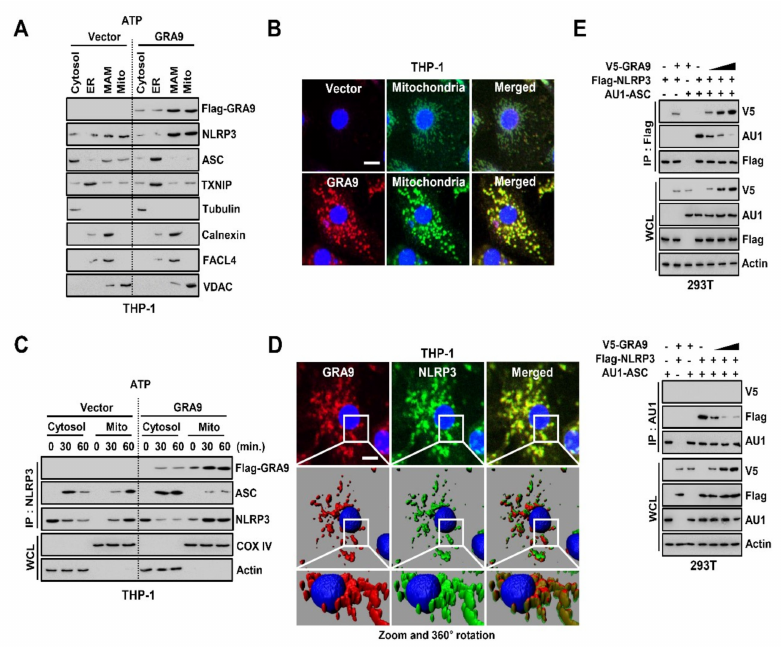
Figure 2. GRA9 associates with NLRP3 inhibiting the binding of ASC in mitochondria. ( A ) Subcellular fractionation of THP-1 cells stably expressing either Vector or GRA9 primed with LPS (100 ng mL − 1 ) and stimulated with ATP (5 mM). Cytosolic, endoplasmic reticulum (ER), mitochondrial-associated membrane (MAM) and mitochondrial fractions were fractionated and analyzed for GRA9, NLRP3, and ASC by immunoblotting (IB). Purify of the fraction was assessed by blotting for TXNIP (thioredoxin-interacting protein; ER protein), tubulin (cytosolic protein), calnexin (MAM protein), FACL4 (acyl-CoA synthetase 4; MAM protein), and VDAC (voltage-dependent anion channel; mitochondrial protein). ( B ) Fluorescence confocal images in THP-1 cells expressing either Vector or rGRA9 were primed with LPS and stimulated with ATP and immunolabeled with α Flag (Alexa 568), MitotrackerDeep Green and DAPI. Scale bar, 10 µ m. ( C ) Vector or GRA9 expressing THP-1 cells were primed LPS (100 ng mL − 1 ) and stimulated with ATP (5 mM) for the indicated times, followed by fractionation. Fractionation of each THP-1 cells were immunoprecipitated by NLRP3 and analyzed by IB with α GRA9, α ASC and α NLRP3. Whole cell lysates (WCLs) were used for IB with α COX IV (mitochondrial protein), and α actin (cytosolic protein). ( D ) Fluorescence confocal images in THP-1 cells expressing either Vector or rGRA9 were primed with LPS and stimulated with ATP and immunolabeled with α Flag (Alexa 568), α NLRP3 (Alexa 488) and DAPI and analyzed in three-dimension. Scale bar, 10 µ m. ( E ) At 24 h after transfection with V5-GRA9, Flag-NLRP3, and AU1-ASC, 293T cells were immunoprecipitated by Flag or AU1, followed IB with α V5, α Flag, and α AU1. Whole cell lysates (WCLs) were used for IB with α V5, α Flag, α AU1, and α actin. The data are representative of four independent experiments with similar results ( A – E ). Full-length images of the blots presented in the Figure